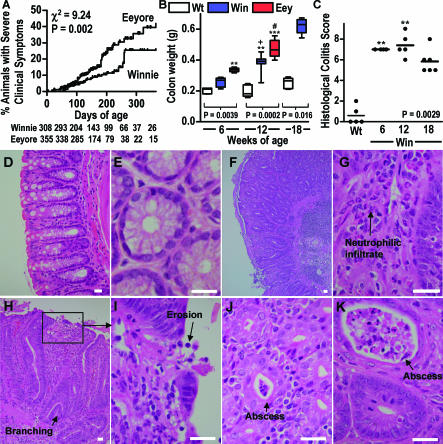
Spontaneous Colitis in Mice with Muc2 Mutations(A) Incidence of premature death or colitis-associated pathology requiring humane killing (chiefly rectal prolapse) in Winnie (n = 309) and Eeyore (n = 355) mice. Mice entering experiments or killed for other reasons were treated as censored observations (designated by upward ticks), and the number of uncensored mice remaining at 50 d intervals is included underneath the graph. Incidence rates in the two strains were compared using the Mantel Log-rank test.(B) Weight of the colon after removal of luminal faecal material in C57BL/6 (WT), Winnie (Win), and Eeyore (Eey) mice at 6 (Eey 6–9 wk), 12, and 18 (WT and Win only) wk of age, n = 4–9; box plots show median, quartiles, and range.(C) Histological colitis scores (see Materials and Methods) in WT and Win mice at 6, 12, and 18 wk of age, n = 4–6; scores from individual mice are shown.(D–K) Histology of normal distal colon from a C57BL/6 mouse (D and E) and examples of inflammation in the rectum (F–I) and distal large intestine (J and K) of untreated Winnie mice showing leukocytic infiltration (G and I), occasional branching crypts (F and H), crypt abscesses (J and K) and focal ulcerations (I); scale bars = 20 μm. Note the layer covering the mucosal surface in (F) is a granulocytic serous exudate.Statistics (B and C): p-values for Kruskal-Wallis nonparametric analysis are shown, Dunn's multiple comparison test versus wild type, ** p < 0.01, *** p < 0.001; versus Win at 6 wk, +
p < 0.05; versus Eey at 6 wk, #
p < 0.05.